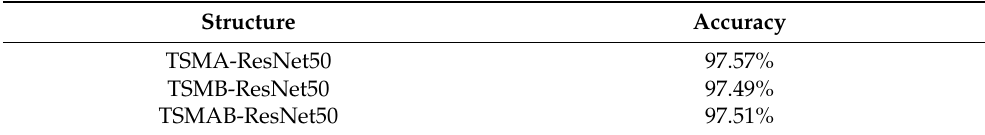
Table 5. Accuracy of TSM-ResNet-50 for ASL Alphabet Dataset.